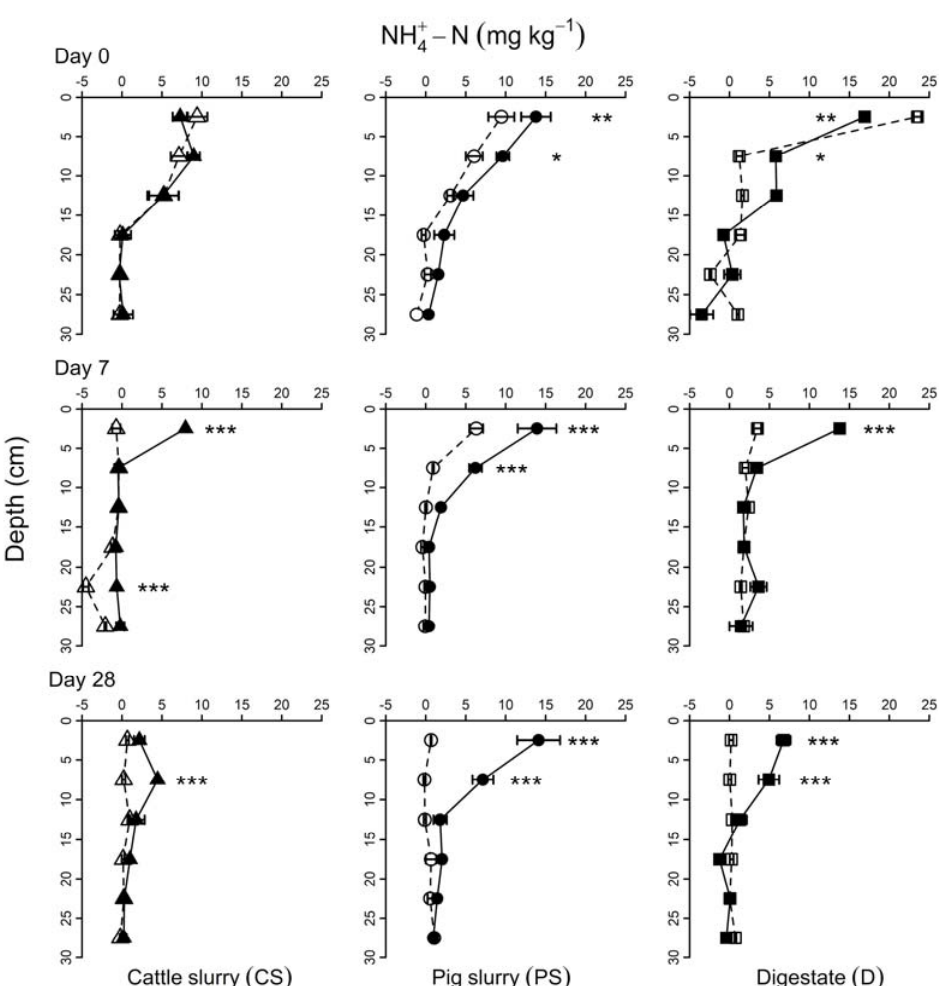
Figure 1. Net ammonia ‐ N (NH 4+ ‐ N) concentration in the soil columns with pig slurry ( ○ ); pig slurry plus N ‐ Lock TM ( ● ); cattle slurry ( ∆ ); cattle slurry plus N ‐ Lock TM ( ▲ ); digestate ( □ ); and digestate plus N ‐ Lock TM ( ■ ). Statistical significance of the differences according to HSD Tukey tests (* P ≤ 0.05; ** P ≤ 0.01; *** P ≤ 0.001).